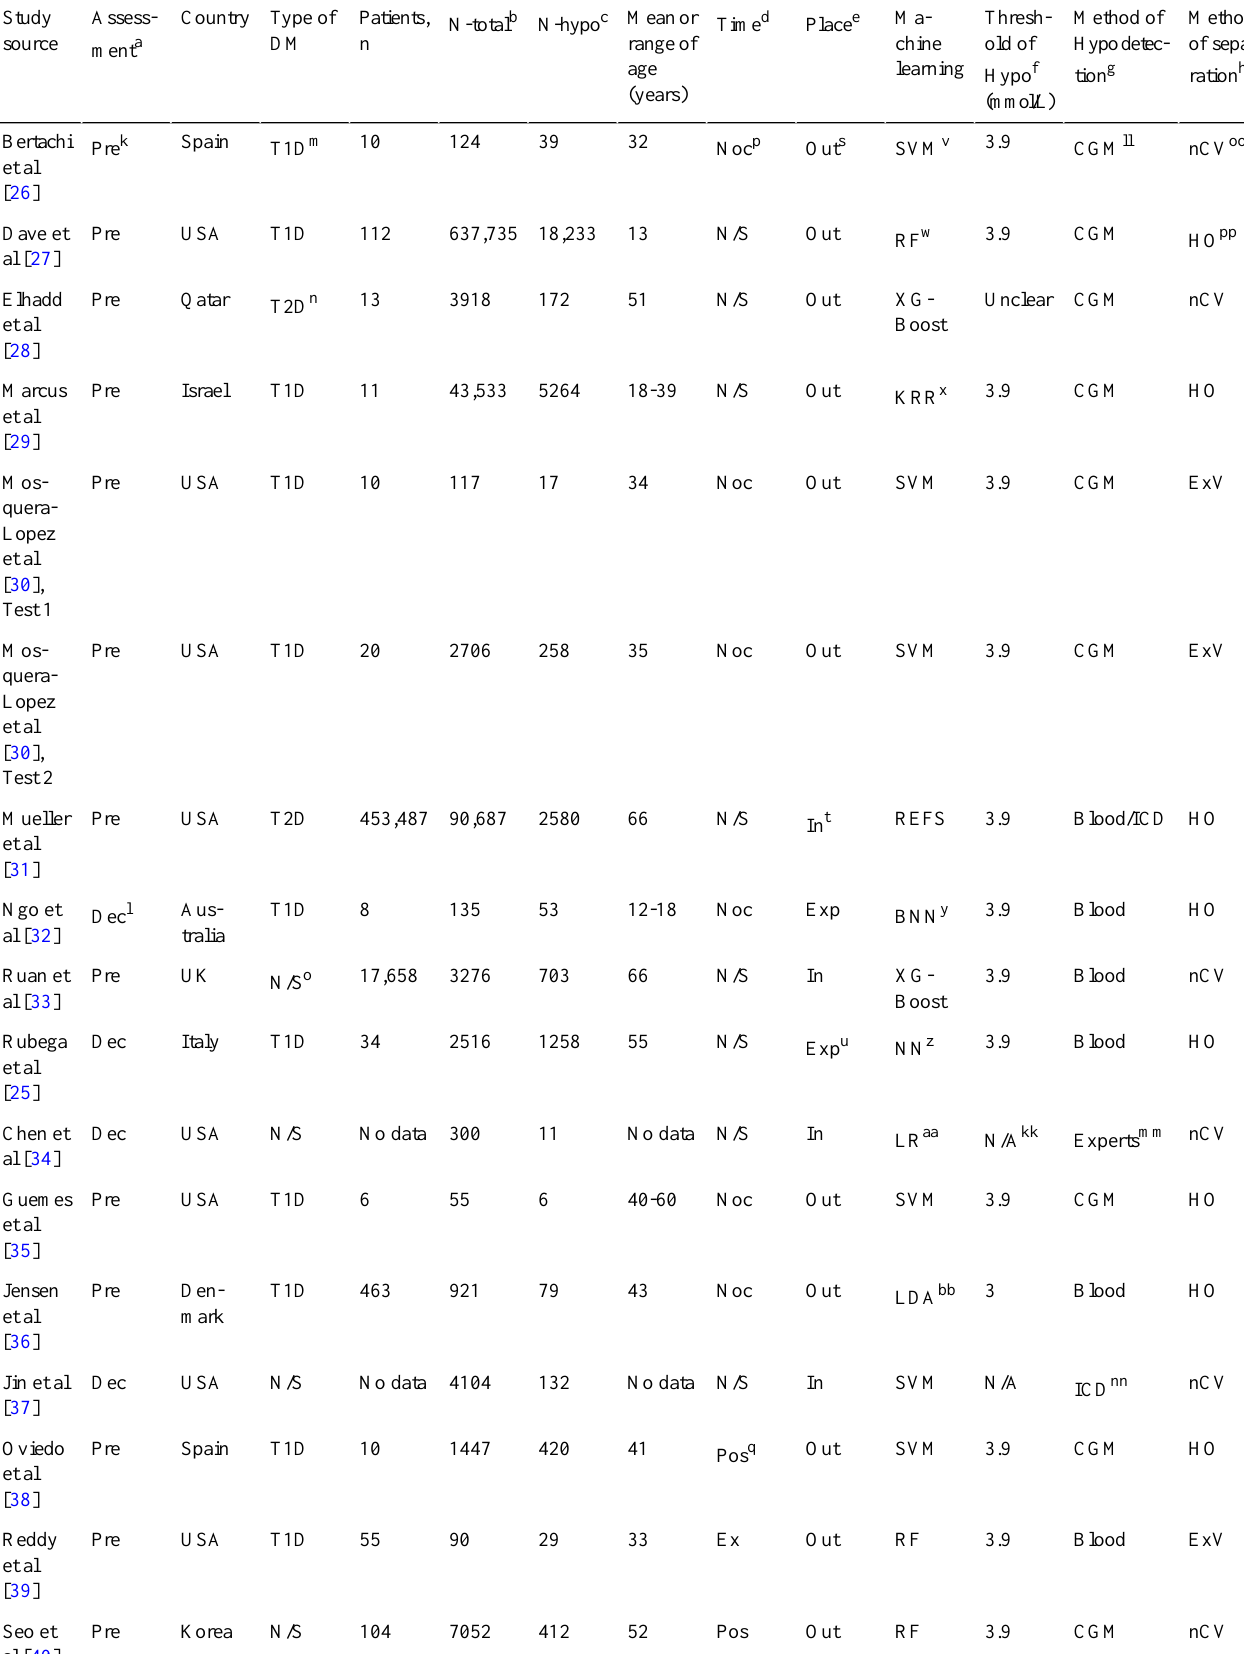
Table 1. Study characteristics of the 33 included studies to assess the ability of machine learning to detect or predict